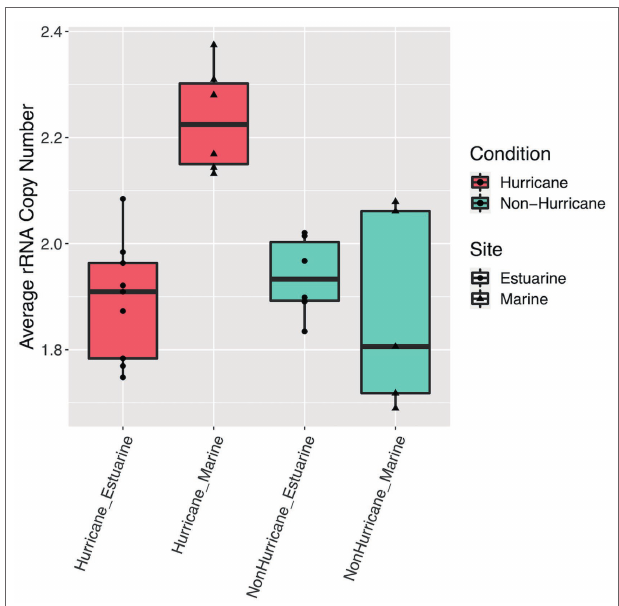
FIGURE 5 | Boxplots of average rRNA ( rrn ) copy number across samples. Hurricane condition marine sites had higher average copy number compared to hurricane condition estuarine sites and all sites from non-hurricane conditions (Mann–Whitney U-test: W = 120, p <